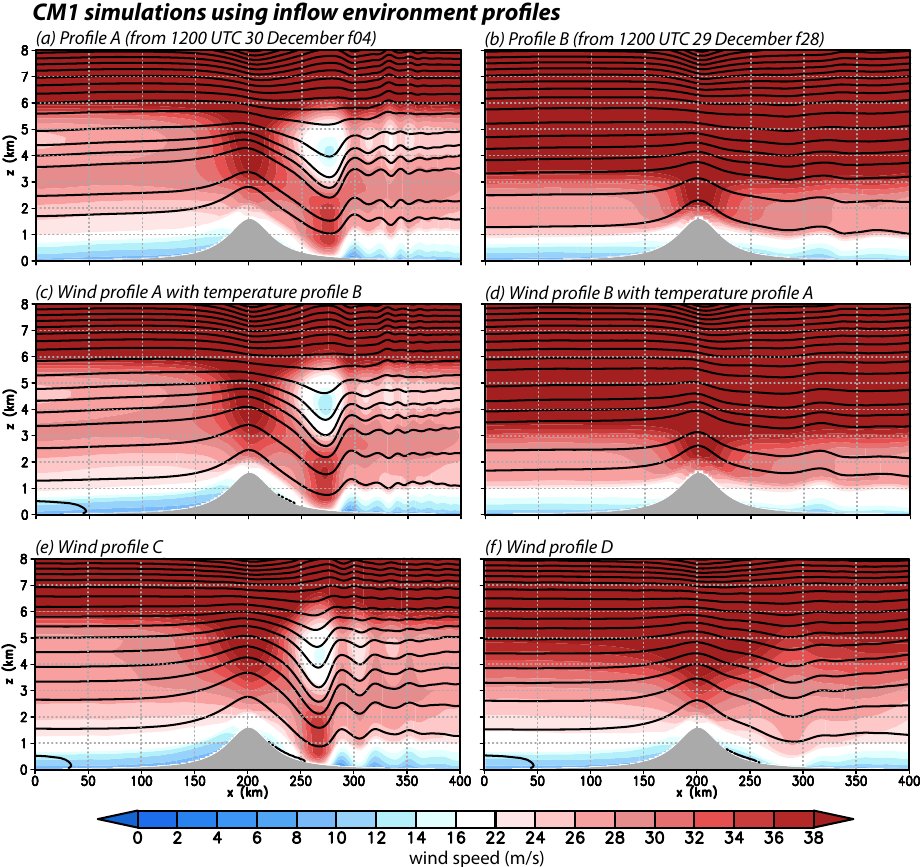
Figure 12. Vertical cross sections of wind speed (shaded, m/s) and potential temperature (3 K contours) from two-dimensional CM1 simulations using a bell-shaped mountain and ( a ) profile A wind and temperature, ( b ) profile B wind and temperature, ( c ) wind profile A with temperature profile B, ( d ) wind profile B with temperature profile A, ( e ) wind profile C, and ( f ) wind profile D. For ( e , f ), temperature profile A was